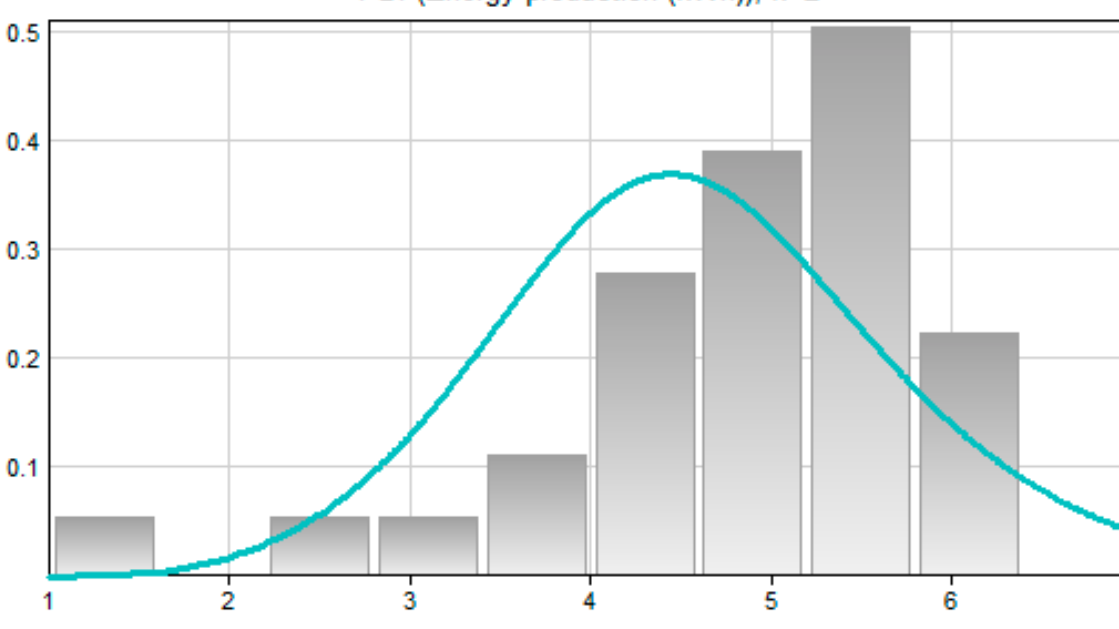
Figure 7. Probability Density Function (sea color line) for the daily energy produced by the WSEI carport in June 2022.